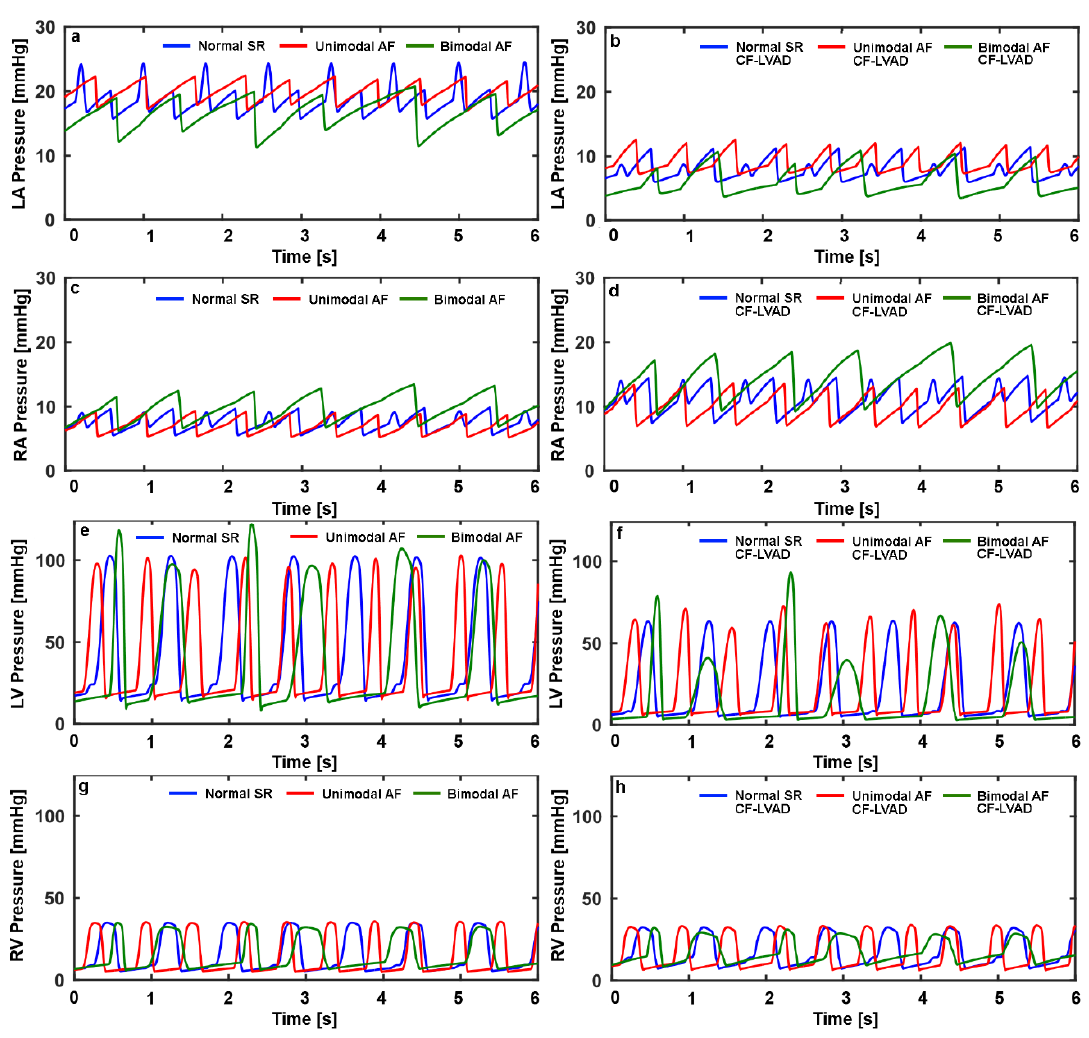
Figure 4. ( a ) Left atrial (LA) pressures for heart failure during normal sinus rhythm (SR) and atrial fibrillation (AF) with unimodal and bimodal RR interval distributions; ( b ) LA pressures for CF-LVAD support during normal SR and AF with unimodal and bimodal RR interval distributions; ( c ) right atrial (RA) pressures for heart failure during normal SR and AF with unimodal and bimodal RR interval distributions; ( d ) RA pressures for CF-LVAD support during normal SR and AF with unimodal and bimodal RR interval distributions; ( e ) left ventricular (LV) pressures for heart failure during normal SR and AF with unimodal and bimodal RR interval distributions; ( f ) LV pressures for CF-LVAD support during normal SR and AF with unimodal and bimodal RR interval distributions; ( g ) right ventricular (RV) pressures for heart failure during normal SR and AF with unimodal and bimodal RR interval distributions; ( h ) RV pressures for CF-LVAD support during normal SR and AF with unimodal and bimodal RR interval distributions.